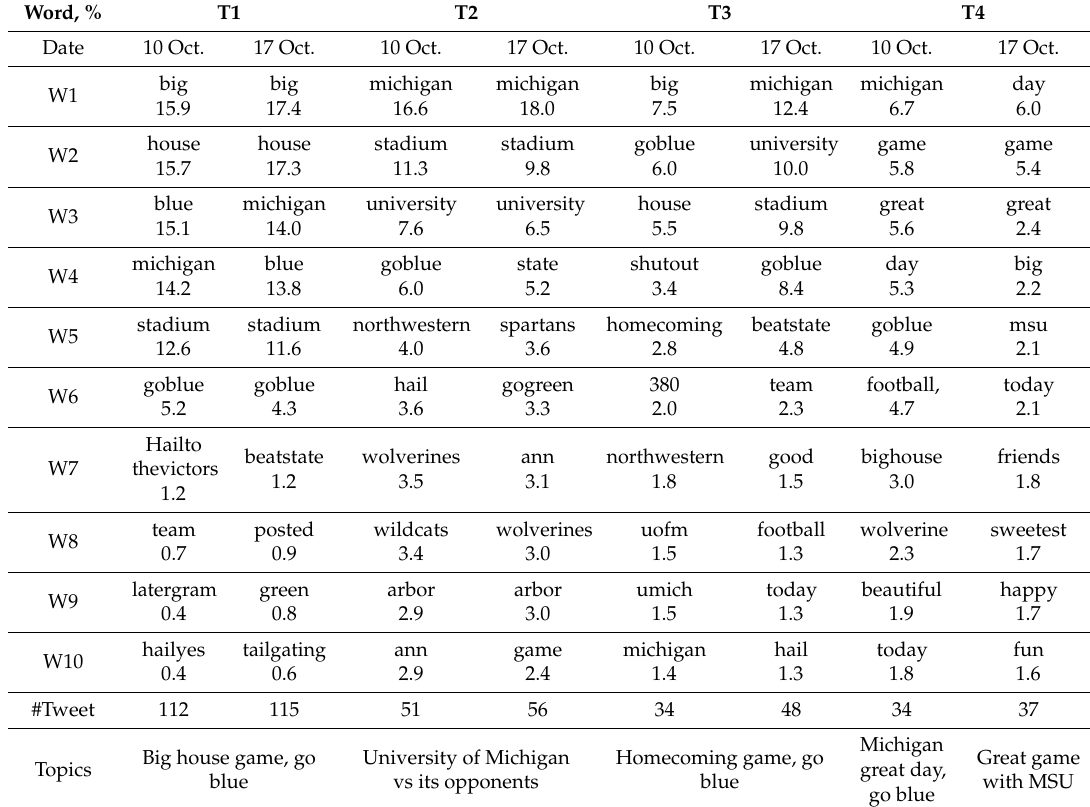
Table 7. Modeled topics for the football games at University of Michigan on 10 and 17 October